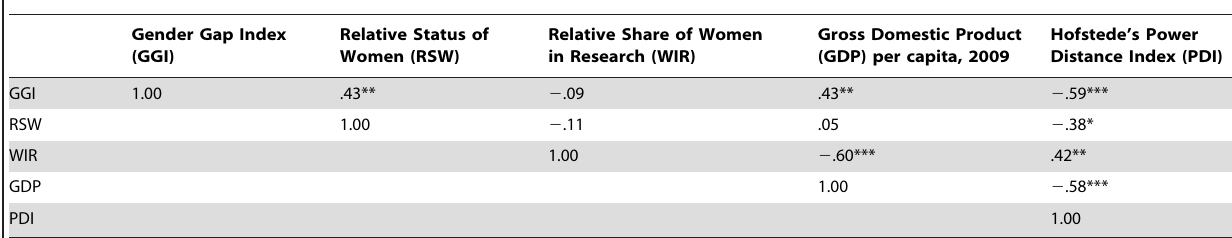
Table 2. Correlations between Measures of Gender Equity, Economic Prosperity, and Hofestede’s Power Distance Index.